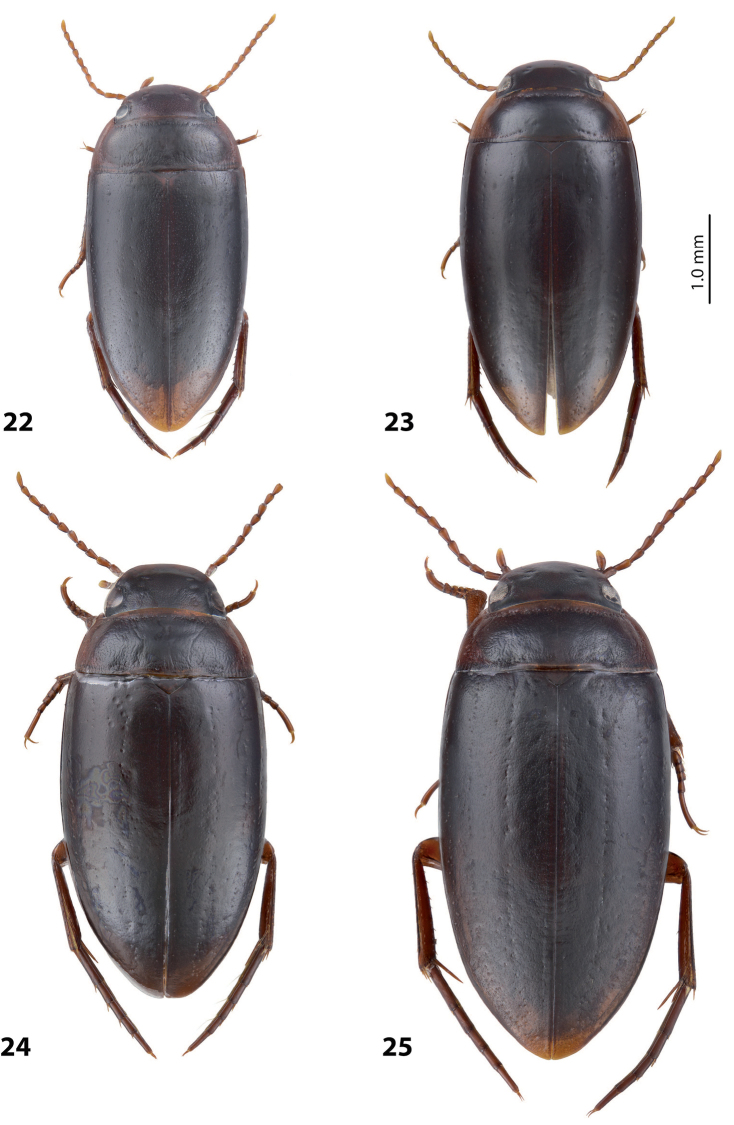
Habitus and coloration 22Exocelinayoginofi sp. n. 23E.okapa sp. n. 24E.mendiensis sp. n. 25E.kumulensis sp. n.